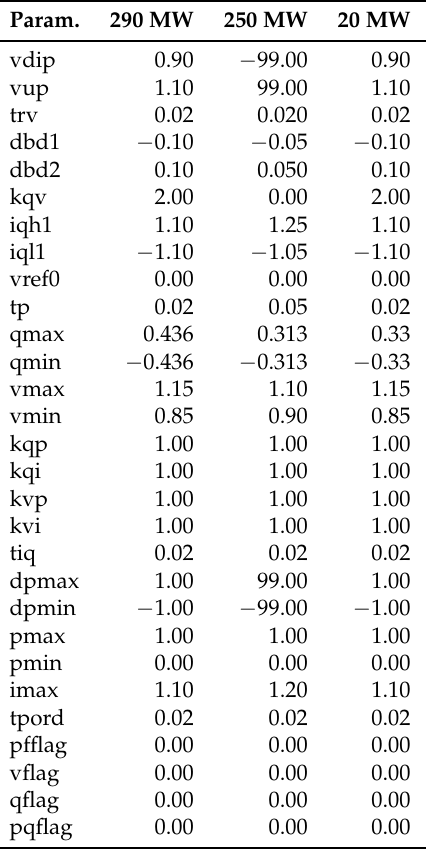
Table A2. REEC-A model: parameters of the solar PV plant. Param. 290 MW 250 MW